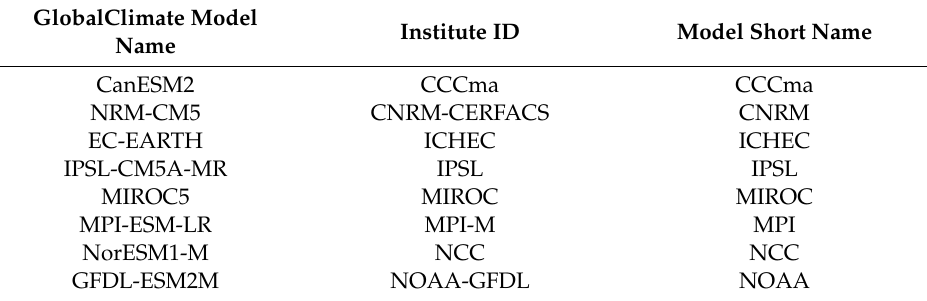
Table 3. The used climatic